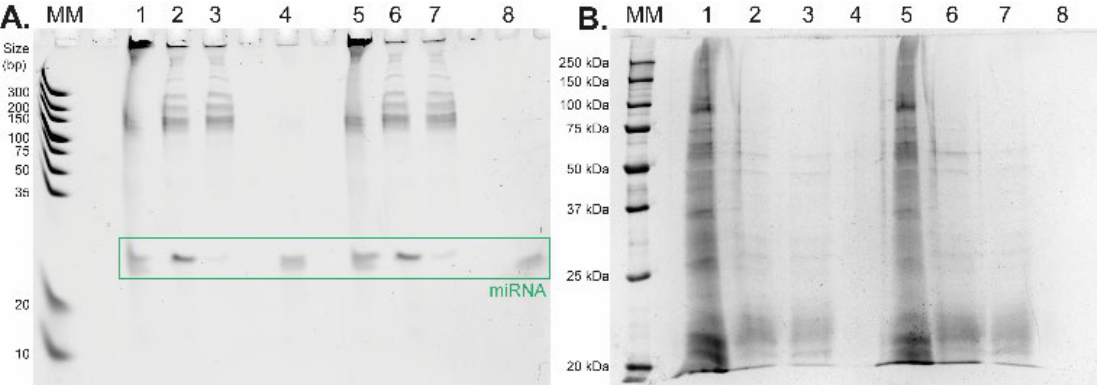
Figure 4. Isolation of miRNAs from cell lysate (Jurkat cells) spiked with oligo RNA standard hsa-miR-18a-3p. ( A ) Urea-PAGE analysis of extraction aliquots (duplicate) in acetate buffer pH 4.4, followed by SYBR Green II staining. MM—marker of nucleotide size (Ultra Low Range DNA Ladder, 10 bp to 300 bp), ( B ) SDS-PAGE analysis of protein purification followed by silver staining. MM—marker of molecular weight (10 to 250 kDa). Lanes: 1, 5—initial cell lysate spiked in with oligo RNA standard; 2, 6—cell lysate after LLE; 3,7—supernatant fraction; 4, 8—elution fraction. Table 2. The relative yields of hsa-miR-18a-3p in fractions obtained during the isolation protocol from cell lysate spiked with hsa-miR-18a-3p.